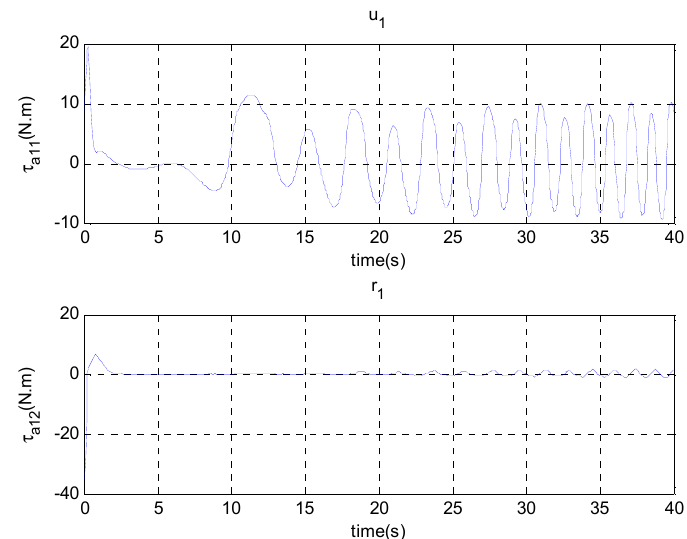
Figure 12. Applied input control of the first follower in Example 2. Appl. Sci. 2019 , 9 , x FOR PEER REVIEW